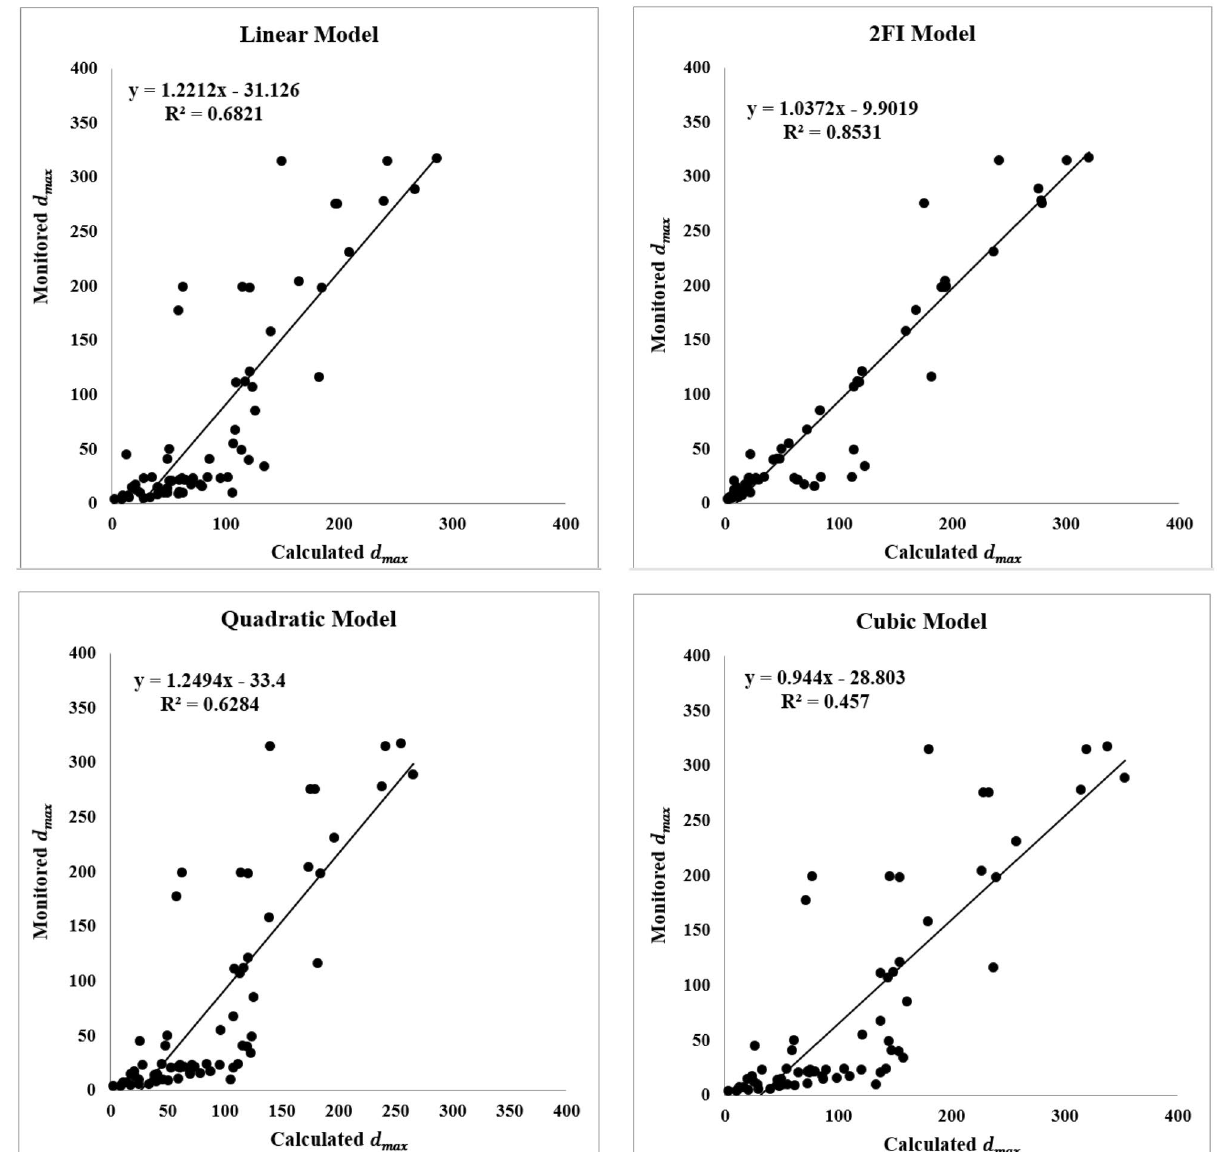
2 Figure 15. R derived from testing on unseen actual data for linear, 2FI, quadratic and cubic